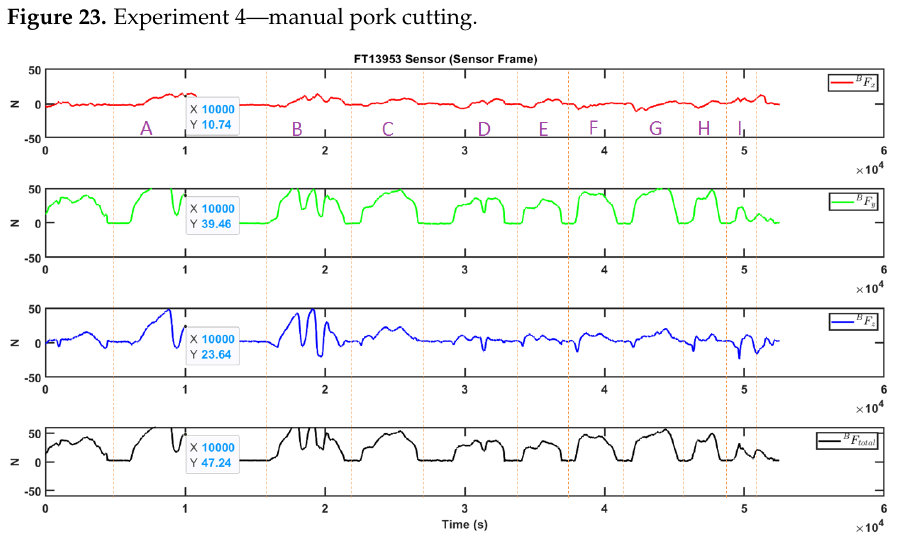
Figure 23. Experiment 4—manual pork cutting.